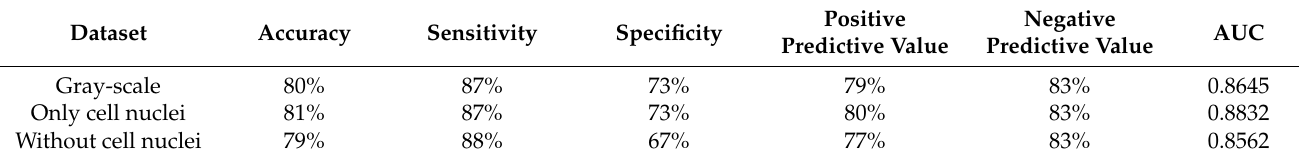
Table 4. Performances of training DenseNet201 on the Lab 1 dataset with gray-scale, only cell nuclei, and without cell nuclei. Dataset